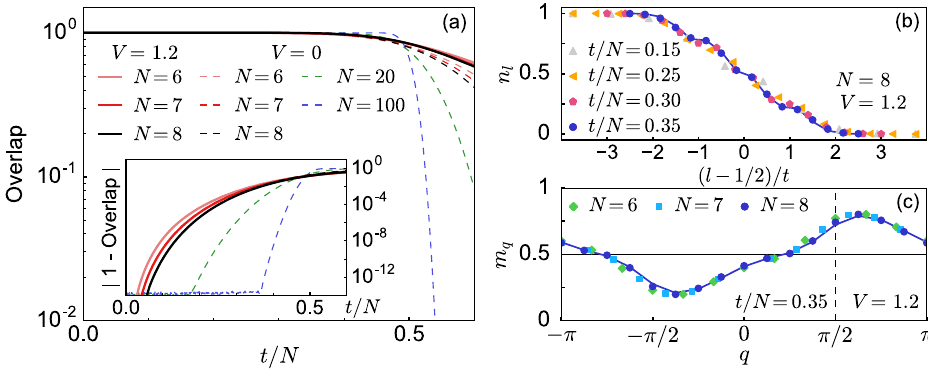
FIG. 4. Emergent Hamiltonian description of the domain-wall melting for interacting spinless fermions. (a) Overlap O ð t Þ ¼ jh Ψ V t j ψ V ð t Þij as a function of rescaled time t=N for V ¼ 1 . 2 (from full exact diagonalization) and V ¼ 0 (noninteracting system), and different system sizes. The inset depicts j 1 − O ð t Þj . For N ¼ 6 , 7, and 8 (see inset), the results for interacting and noninteracting fermions are virtually indistinguishable at short times. Results for larger system sizes are only available for the noninteracting case. (b),(c) Site and quasimomentum occupations for V ¼ 1 . 2 obtained from j ψ V ð t Þi (symbols) and from j Ψ V t i (lines) (data shown for N ¼ 8 at time t=N ¼ 0 . 35 ). (b) Site occupations n l ð t Þ for N ¼ 8 and different times as a function of the rescaled coordinate ð l − 1 = 2 Þ =t . The data collapse onto a line [57] as for noninteracting particles [40]. (c) Quasimomentum distribution function m q ð t Þ for different system sizes and the same rescaled time t=N ¼ 0 . 35